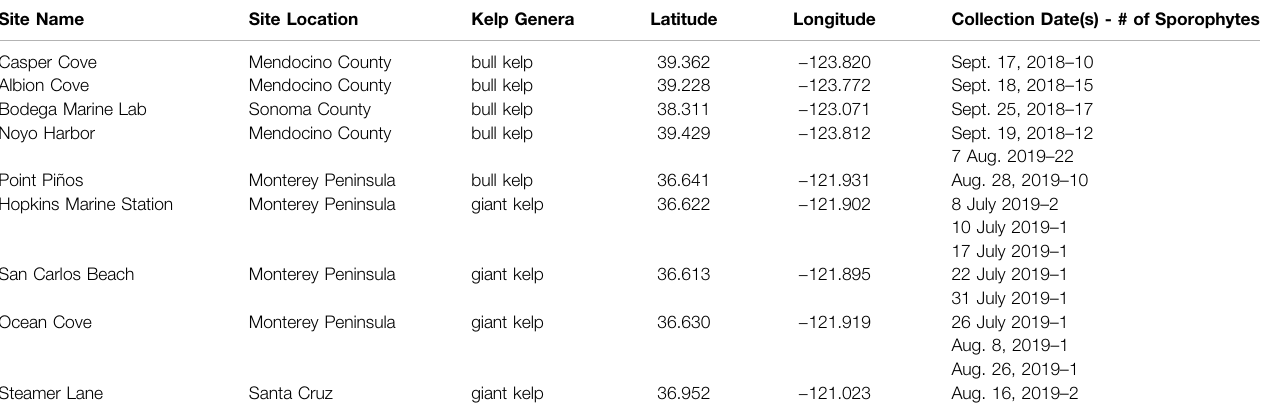
TABLE 2 | Detailed information of site-speci fi c sporophyte collection including site name, region, kelp genera, latitude/longitude, and collection